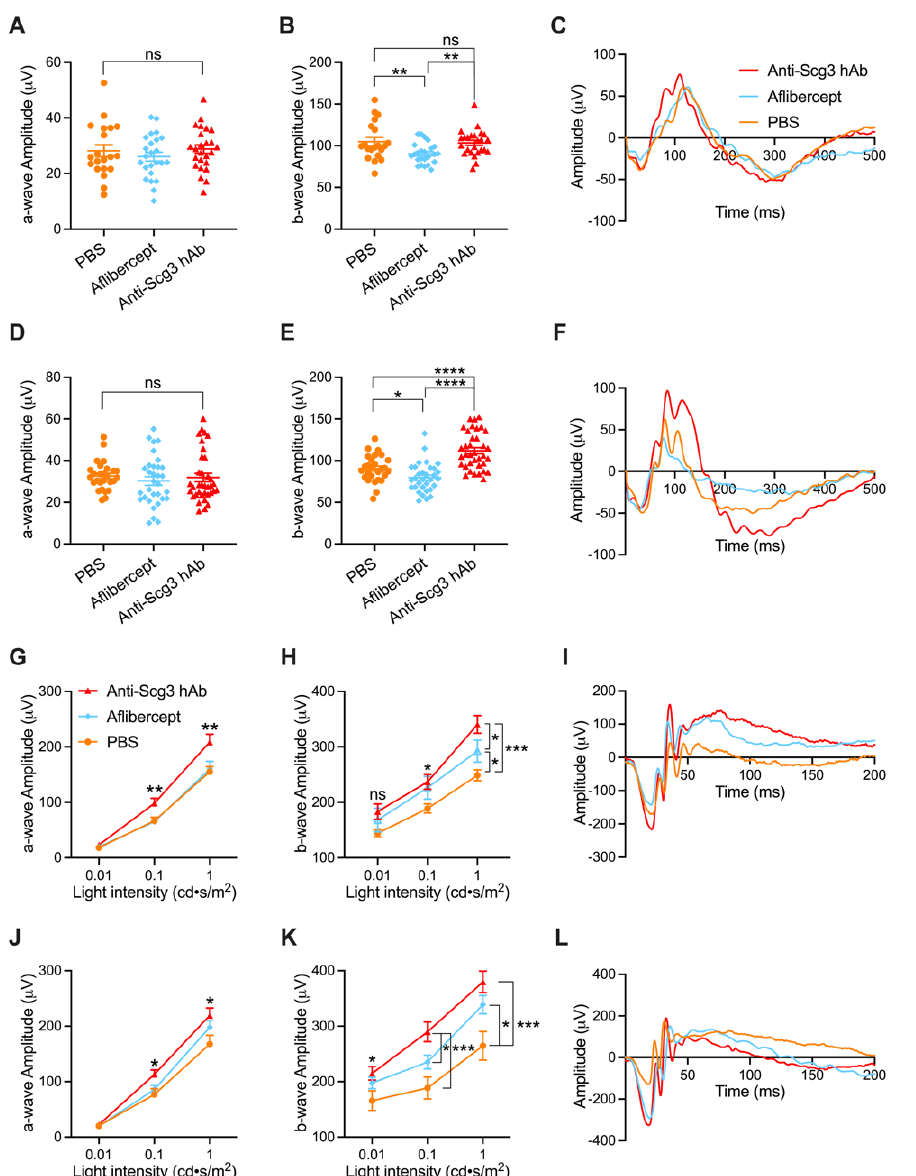
Figure 3. Intravitreal anti-Scg3 hAb improves short- and long-term visual function in OIR mice. ( A – C ) Short-term pfERG of OIR mice at P21 (7 DPI). a-wave amplitude remained unchanged between groups ( A ). Intravitreal aflibercept suppressed b-wave amplitude ( B ). n = 20 eyes (PBS), 24 (afliber- cept), and 25 (anti-Scg3 hAb). ( D – F ) Long-term pfERG of OIR mice at P42 (28 DPI). a-wave ampli- tude was unchanged ( D ). Anti-Scg3 improved b-wave amplitude, whereas aflibercept decreased the